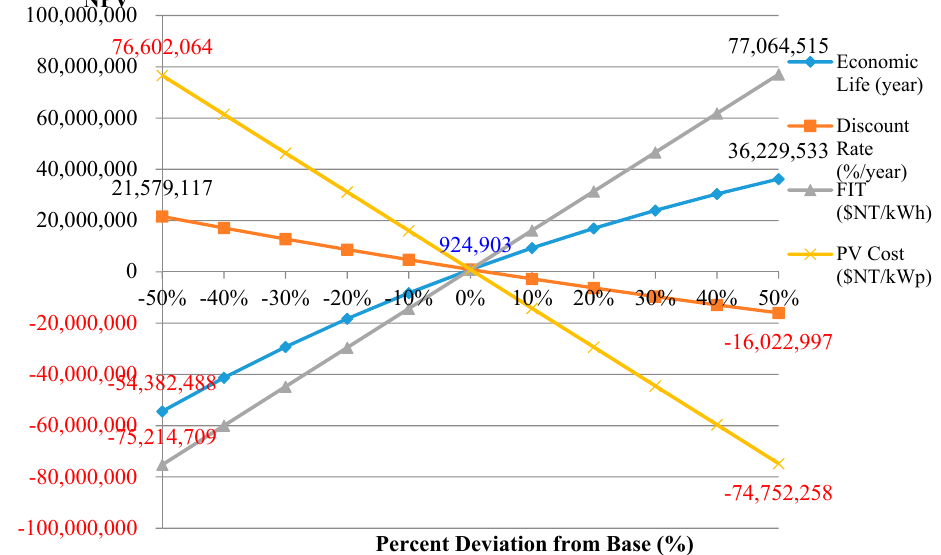
Figure 11. NPV sensitivity graph for four key parameters.